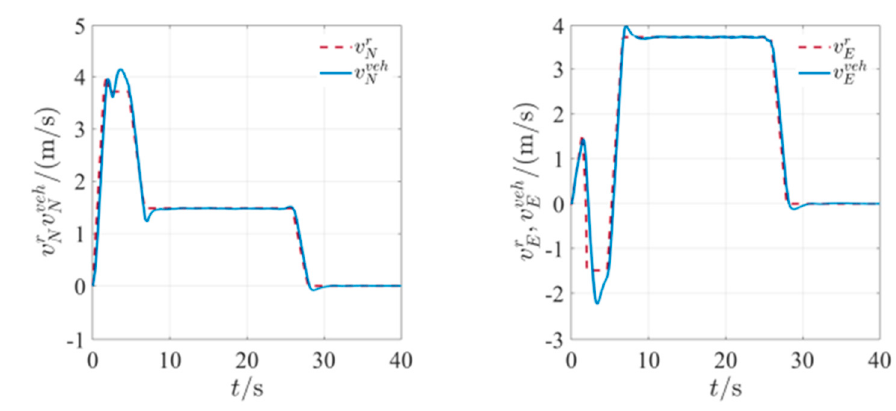
Figure 20. Height diagram of line tracking.